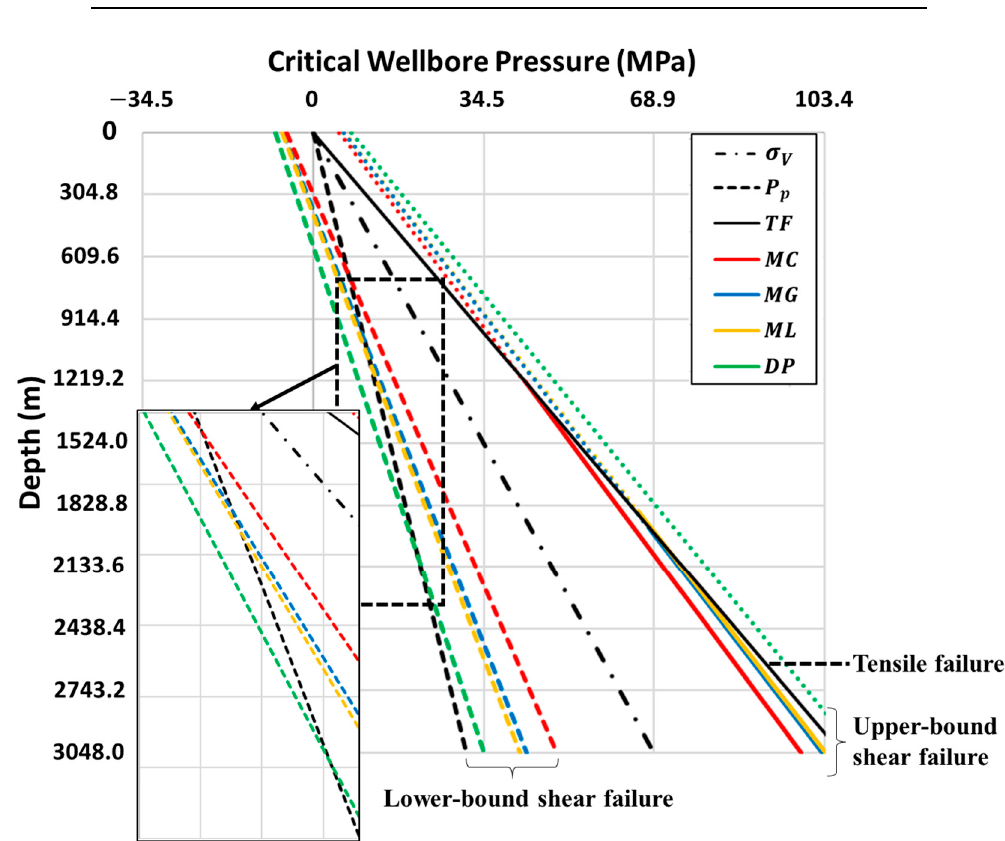
Figure 2. Reverse faulting regime - compressional basin. Critical wellbore pressure at lower- (colored dashed), upper-bound shear (colored solid), and tensile (TF; black solid) failures under the reverse faulting regime with the vertical, maximum and minimum horizontal stress gradients of 22.6, 29.4, and 24.9 kPa/m, respectively. The pore pressure gradient is 10.2 kPa/m (black dashed). The wellbore pressures were calculated by the Mohr–Coulomb (MC; red), Mogi–Coulomb (MG; blue), modified Lade (ML; yellow), and Drucker–Prager (DP; green) failure criteria. The vertical in-situ stress is depicted with the dash-dotted black line. The magnified frame indicates that the calculated lower critical wellbore pressures exceed the pore pressure at certain depths. Input parameters are given in Tables 2 and 3.